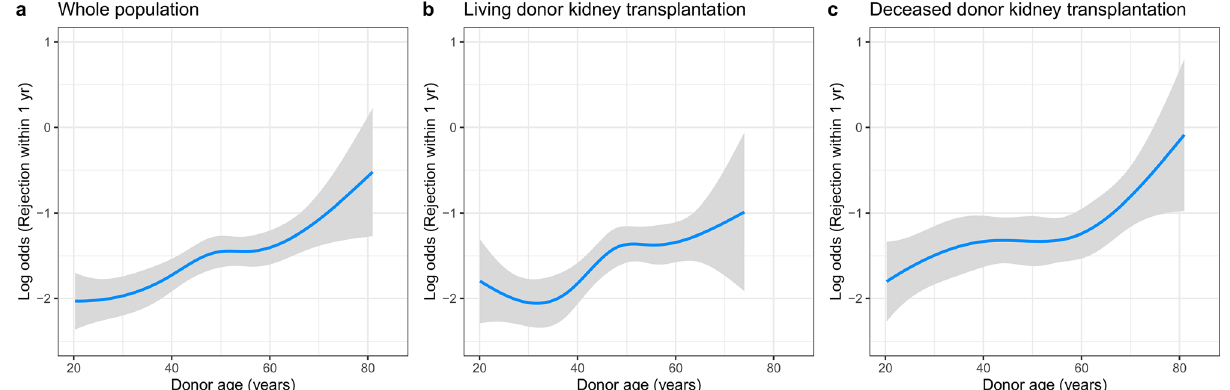
Figure 5. Visualization of log odds of acute rejection within 1 year according to different donor age ( a ) Visualization of log odds of acute rejection within 1 year according to different donor age in overall study population ( b ) Stratified log odds of acute rejection within 1 year according to different donor age in living donor kidney transplantation subpopulation ( c ) Stratified log odds of acute rejection within 1 year according to different donor age in deceased donor kidney transplantation subpopulation. Blue line indicates adjusted logarithm of odds of acute rejection within 1 year according to different donor age in each group. Each grey area indicates its 95% confidence interval. All graphs are the results of multivariable regression analyses which included donor age, HLA mismatch numbers, desensitization, recipient sex, recipient age, donor hypertension, recipient blood pressure, deceased donor, duration of renal replacement therapy, ever smoking in